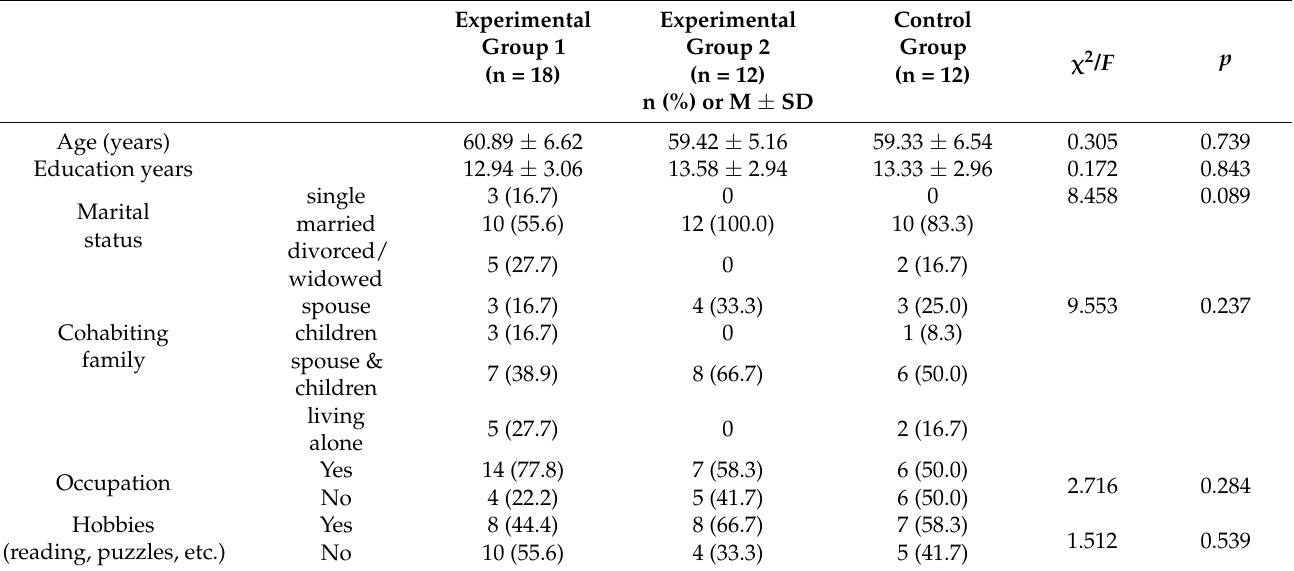
Table 1. Demographic characteristics of participants (N = 42). Experimental Group 1